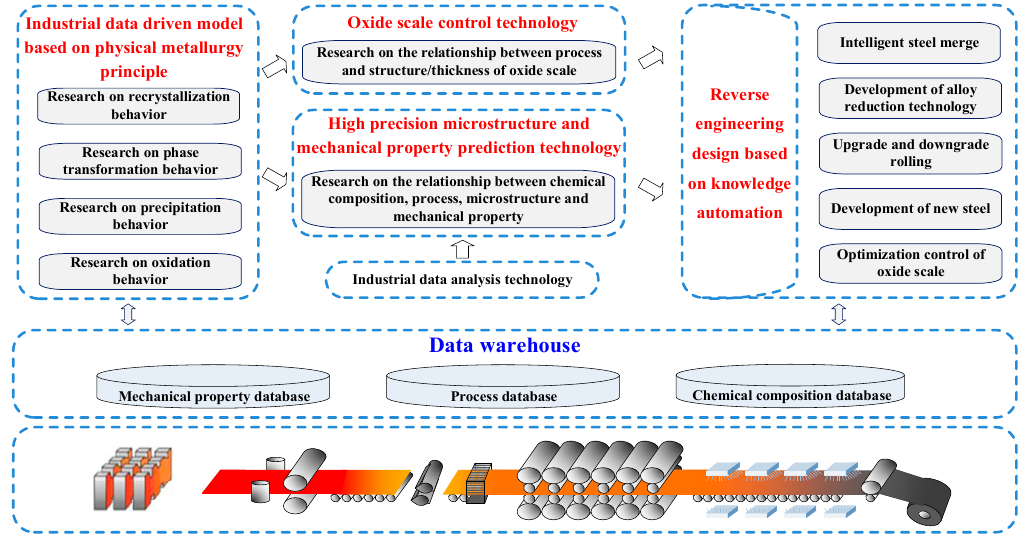
Figure 4. Temperature control-deformation coupling-property matching and intelligent control technology of surface quality in hot rolling process.